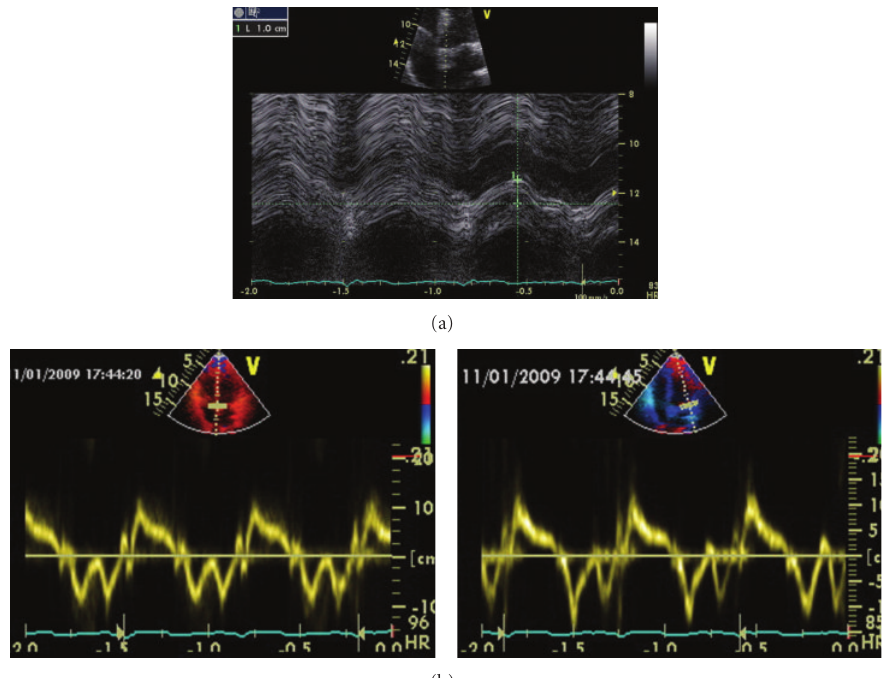
Figure 1: Methods for measuring LV function. (a) Atrioventricular plane displacement (septal wall) using M-mode, showing abnormal (decreased) displacement. (b) Systolic tissue Doppler measurement at the septal and lateral walls using tissue velocity imaging with pulsed wave Doppler, showing normal velocities.